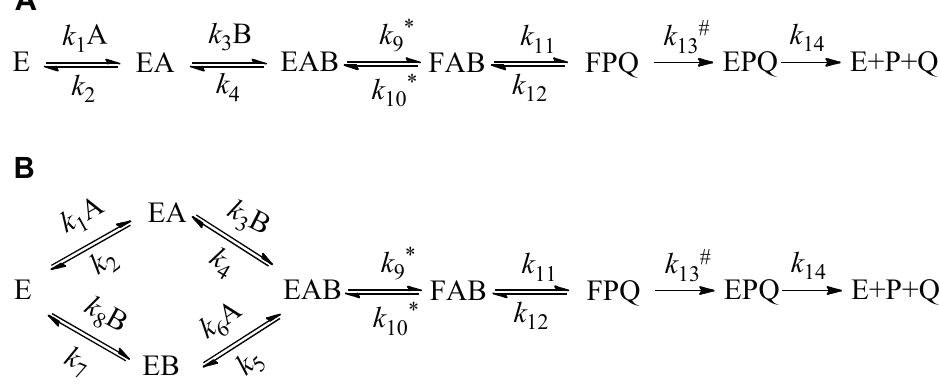
Figure 4. Binding Scheme for a Sequential Ordered Mechanism ( A ); and random binding mechanism ( B ). In the case of TSase, substrate A would be dUMP and B would